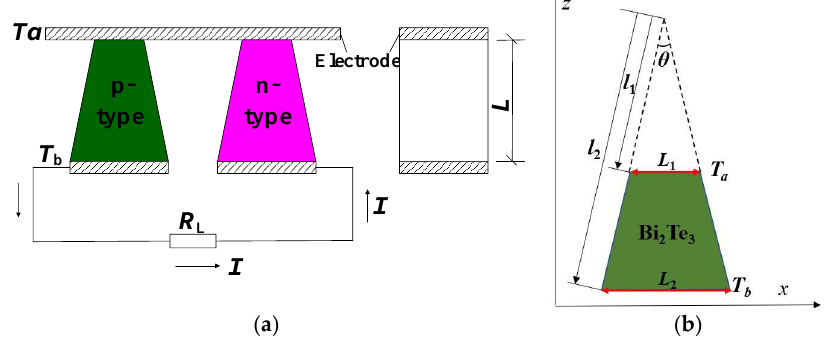
Figure 2. Schematic of ( a ) trapezoidal thermoelectric generator and ( b ) thermoelectric legs.